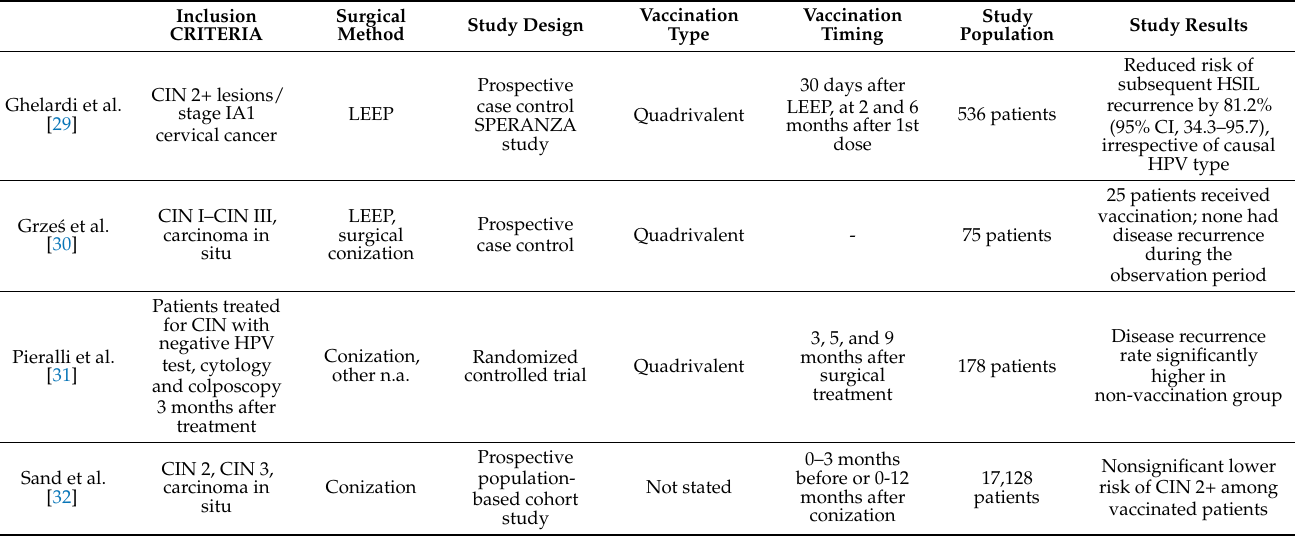
Table 2. Prospective studies evaluating the effectiveness of HPV vaccination after surgical